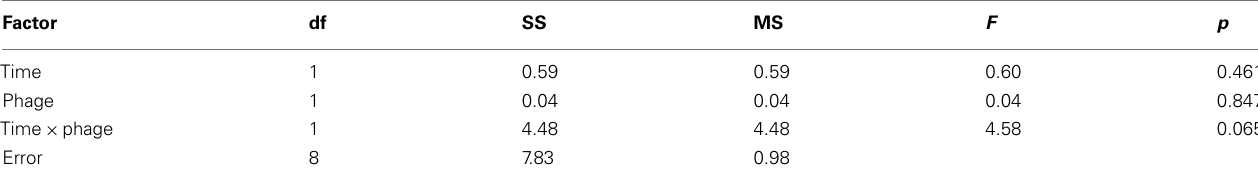
Table 2 |ANOVA results on the number of morphotypes (time-averaged for days 8–10) for focal genotypes introduced 24h after the competitor genotype.